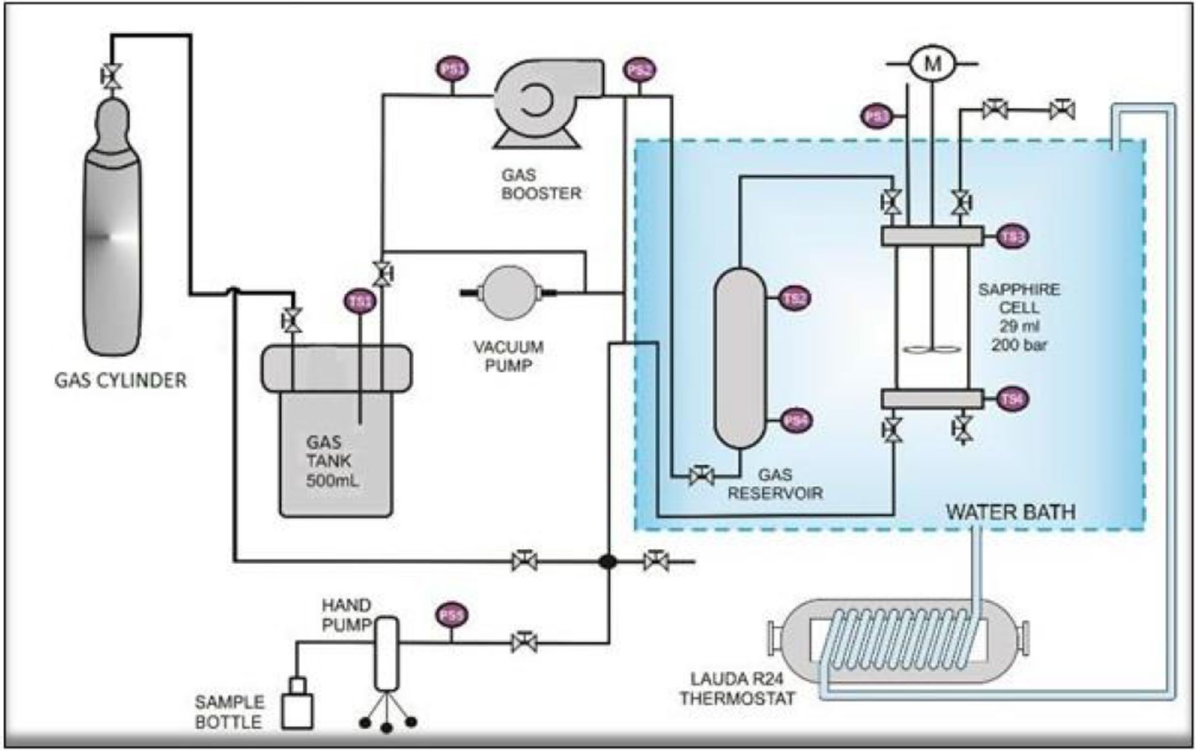
Figure 7. Schematic diagram of the experimental apparatus in this work 41